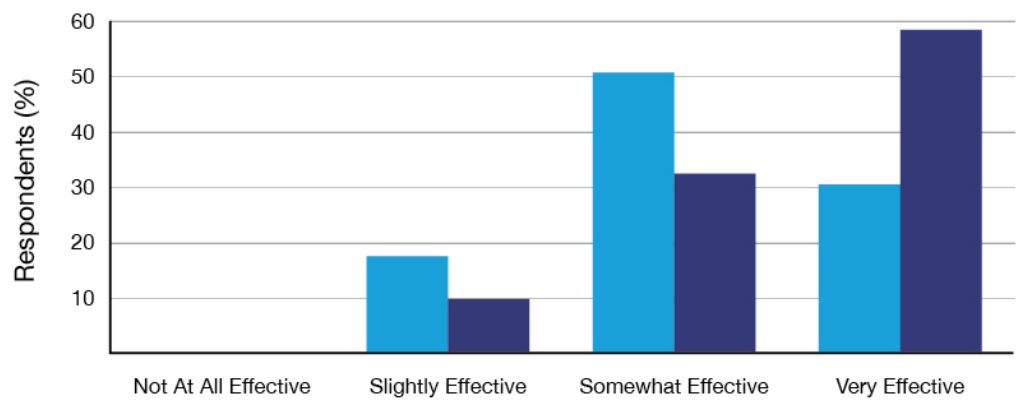
Figure 3. Perceived effectiveness of smartphone diet apps in assessing dietary intake